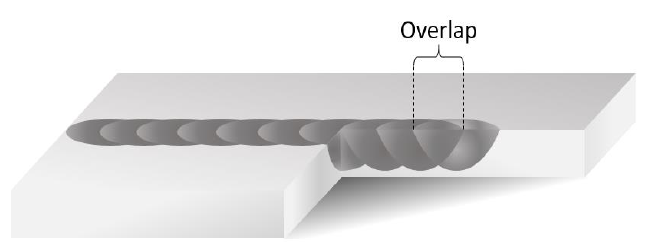
Figure 2. Overlapping schematically illustrated. Adapted with permission from [41]. Copyright 2014 Elsevier.